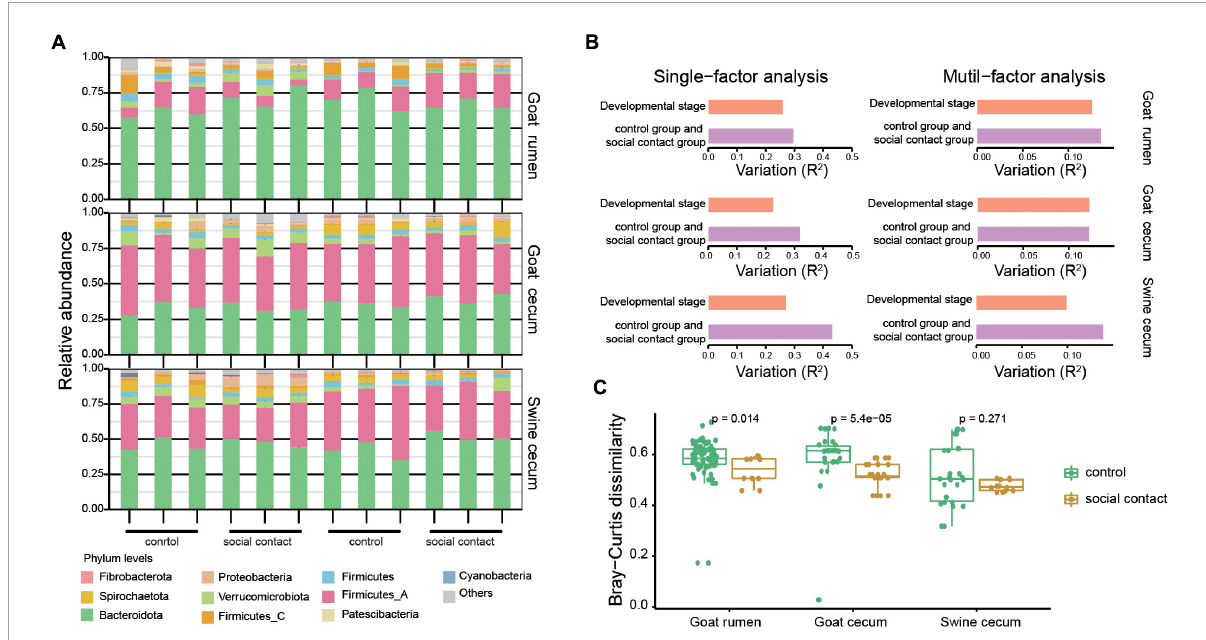
FIGURE2 Change in the gut microbiota following environmental conversion. (A) Relative abundance of microbial phyla for the goat rumen, goat cecum, and pig cecum samples. (B) A bar plot summarizing the results of single and multiple factors permutational multivariate analysis of variance (PERMANOVA) results in the goat rumen, goat cecum, and pig cecum samples. The variations were derived from the between-sample Bray-Curtis distance. (C) Stability of strain-level composition profiles between control and social contact group as measured by Bray-Curtis dissimilarity. The Wilcoxon rank-sum test was used to assess the